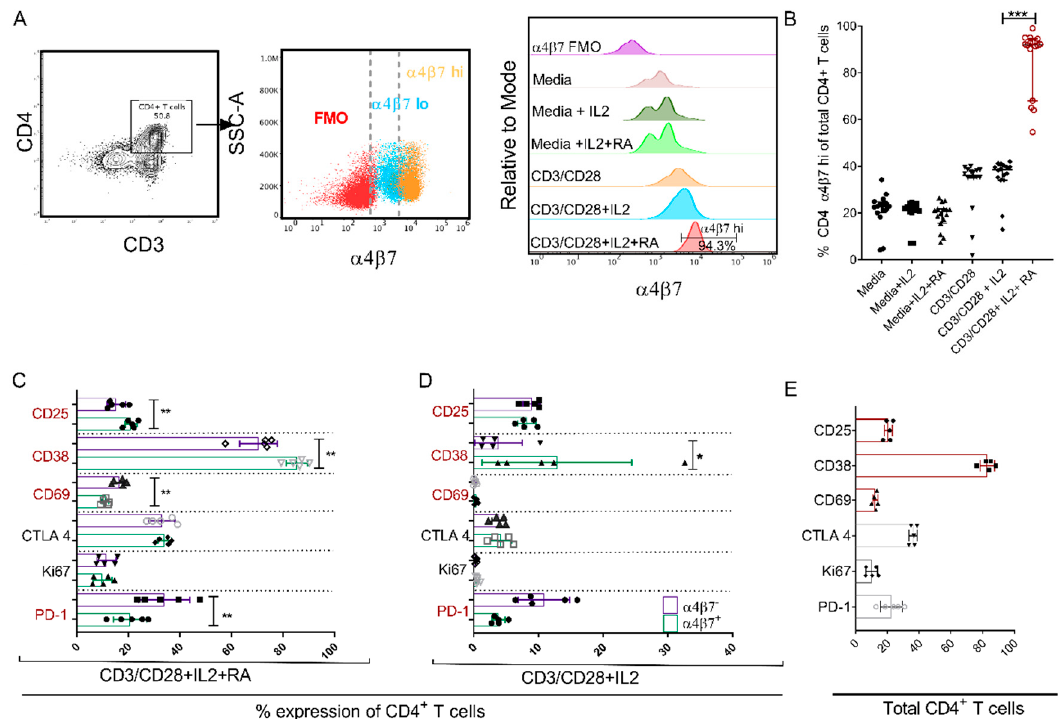
Figure 3. The addition of RA upregulates α 4 β 7 hi expression on CD4 + T cells cultured under different conditions resulting in distinct immune activation profiles between α 4 β 7 + and α 4 β 7 − CD 4 + T cells. Flow cytometry gating strategy showing: ( A ) CD4 + T cells derived from CD3 + /lymphocyte/live and single cells and later profiled for the extent of α 4 β 7 expression. Following this is an overlay dot plot showing the spread of α 4 β 7 (Fluorescence minus one (FMO)—red, α 4 β 7 lo—blue and α 4 β 7 hi—orange) within the CD4 + population. Then, adjacent to this is a representative overlay histogram generated after flow cytometry analysis indicating levels of α 4 β 7 hi expression on CD4 T cells normalized to mode following the culturing of PBMCs under the different conditions: media only, media + IL-2, media + IL-2 + RA, anti-CD3/CD28, anti-CD3/CD28 + IL-2, anti-CD3/CD28 + IL-2 + RA and α 4 β 7 FMO as a control. ( B ) Aligned dot plot showing the frequency of CD4 + α 4 β 7 hi T cells in total CD4 + T cells obtained from 16 naive RMs and cultured under different conditions named in ( A ). ( C ) Percent expression of differences in IA markers CD38, CD69, CTLA 4, Ki67 and PD-1 expressed on α 4 β 7 + vs. α 4 β 7 − CD4 + T cells after cell culture in media comprising of anti CD3/CD28 beads, IL-2 and RA ( n = 5 rhesus macaque PBMCs) and ( D ) α 4 β 7 + vs. α 4 β 7 − CD4 + T cells following cell culture media containing anti CD3/CD28 beads and IL-2 ( n = 5 rhesus macaque PBMCs). ( E ) Levels of percent expression of several immune activation (IA) markers (Ki67, CD25, CD38, CD69 and PD-1) on total CD4 + T cells. * shows p < 0.05, ** indicates p < 0.001 while *** denotes p < 0.0001 resulting from Wilcoxon matched pairs signed rank tests between paired groups of the different comparisons.